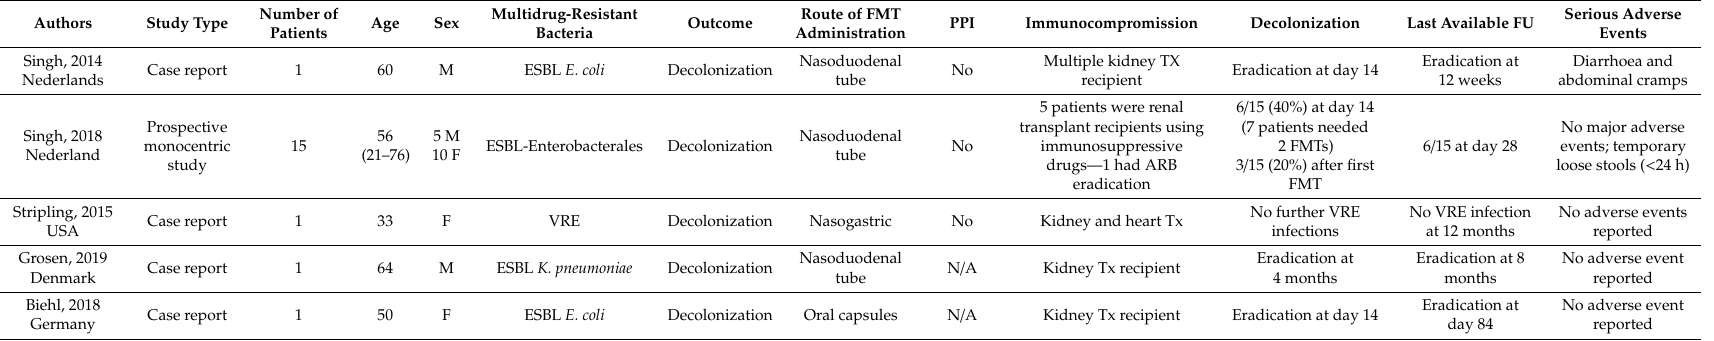
Table 1. Fecal microbiota transplantation (FMT) for multidrug-resistant (MDR) decolonization in solid organ transplant